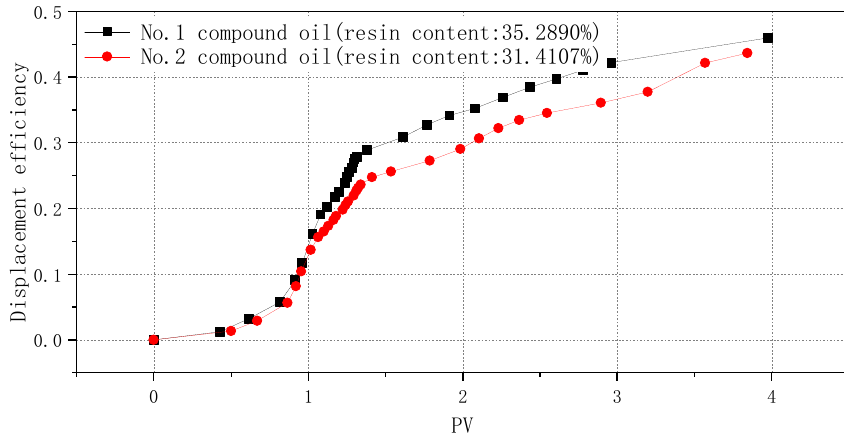
Figure 2. Displacement efficiency of two different compound oil.